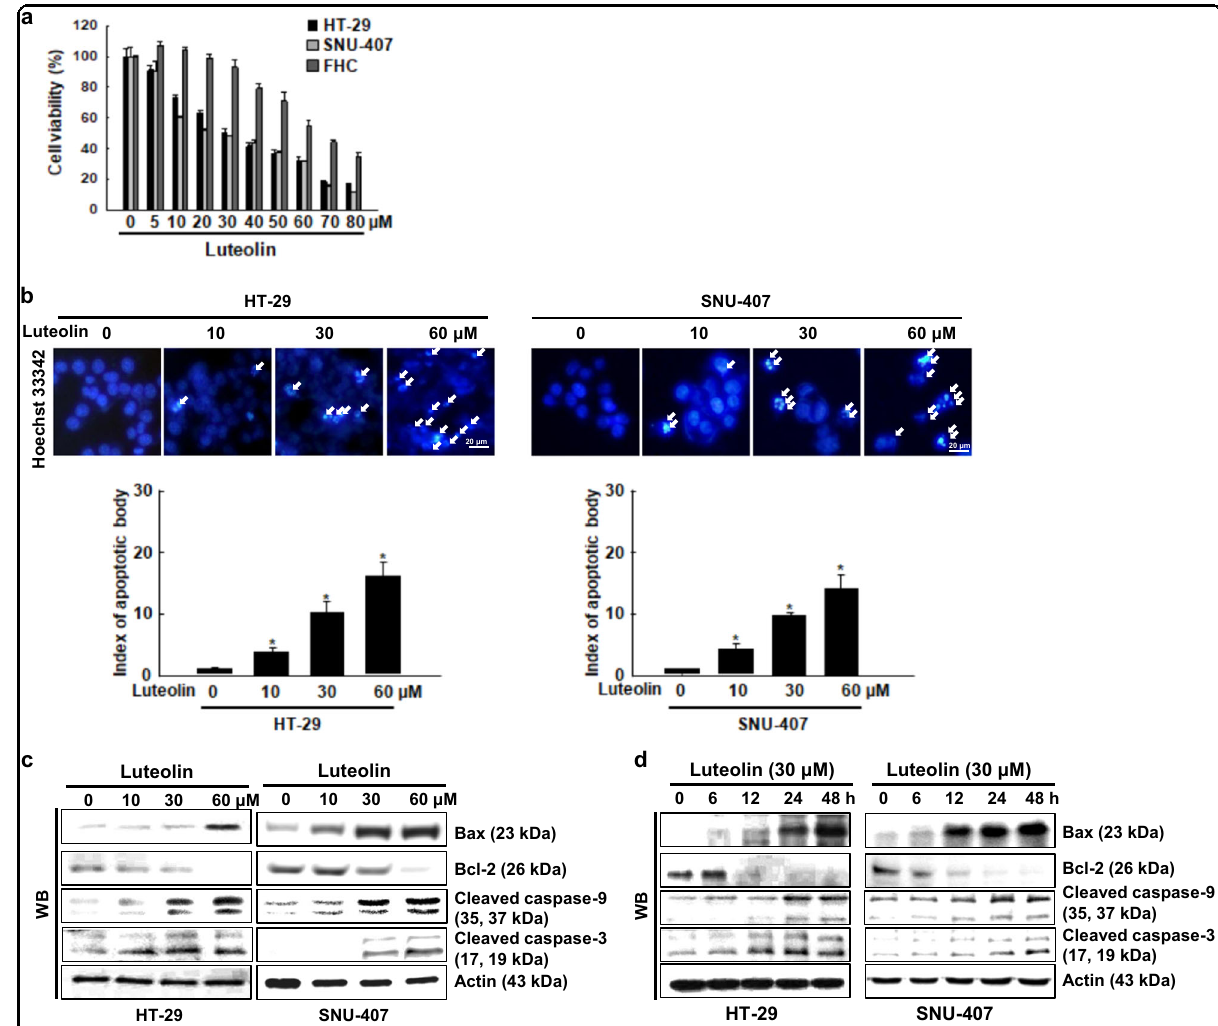
Fig. 1 Luteolin elicits cytotoxic effects on human colon cancer cells by inducing apoptosis. a HT-29, SNU-407, and FHC cells were treated with various concentrations of luteolin for 48 h, and their viability was assessed using the MTT assay. IC 50 , de fi ned as the concentration that inhibited cell growth by 50%, was determined. b Apoptotic body formation was observed using a fl uorescence microscope after cells were stained with Hoechst 33342. Arrows indicate apoptotic bodies; * p < 0.05 compared with control cells. Cells were treated with c various concentrations of luteolin for 48 h or d 30 µM luteolin for various durations. Cell lysates were electrophoresed, and Bax, Bcl-2, active caspase-9, and active caspase-3 proteins were detected using speci fi c